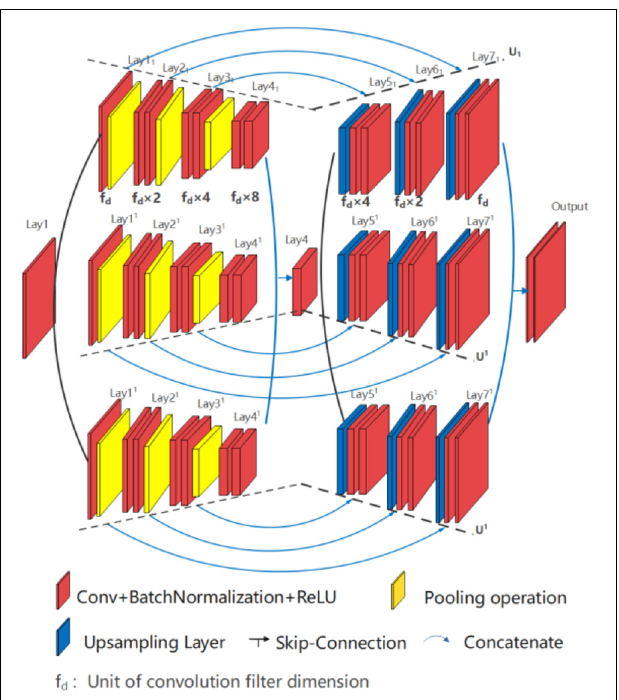
FIGURE 8 | Structure diagram of U ∗ U ∗ UNet U 1 (4)//U 1 (4)//U 11